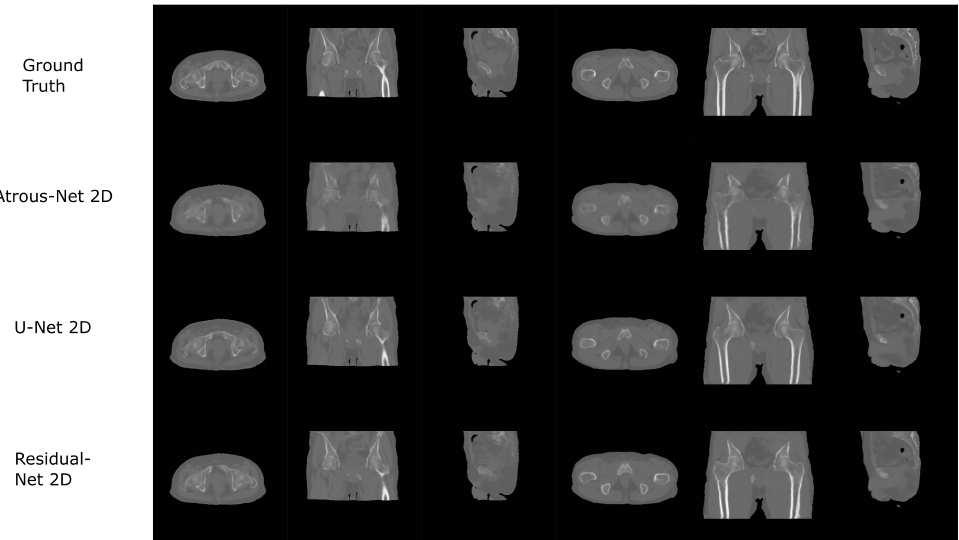
Figure 8. Pelvis results using 2D networks.